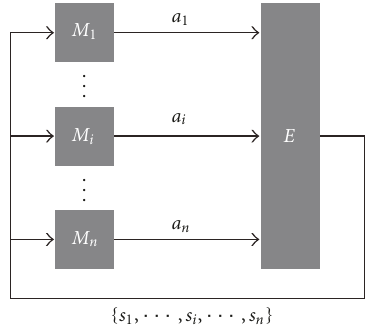
Figure 13: Overview of the multiagent simulation environment. The agents, M i , generate actuation functions, a i , as static functions of their sensory perception, s i , of the environment, E